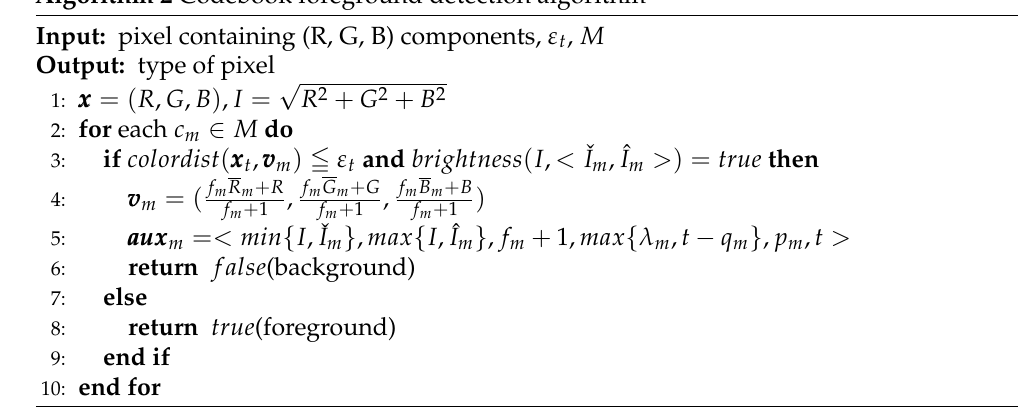
Algorithm 2 Codebook foreground detection